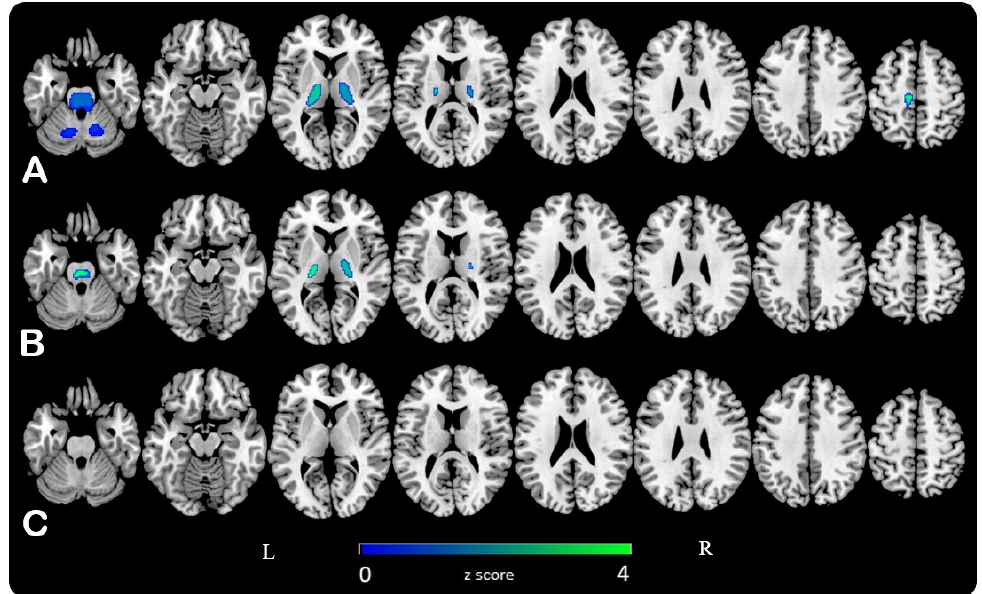
Figure 2. Statistical parametric maps (SPMs) are represented on a color-coded scale (0 < z < 4) and displayed on a standardized brain magnetic resonance imaging. The relative positive correlation between age and FDG uptake in thalami, brainstem and cerebellum when cerebral global mean ( A ) was considered as normalising reference, decreased until is no more evident scaling to white matter ( B ) and pons ( C ) 18F-FDG activity, respectively.